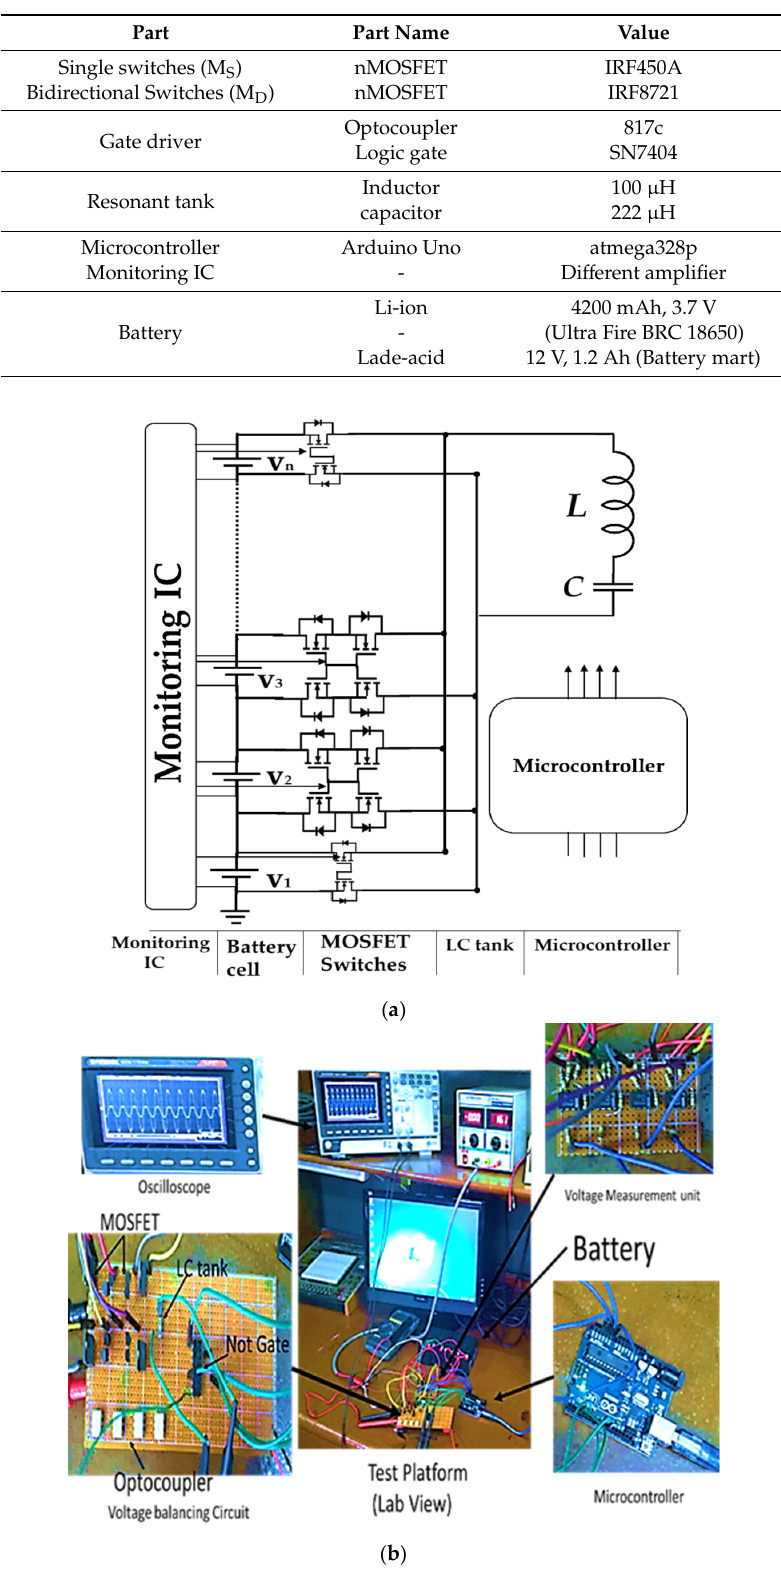
Figure 9. Hardware development: ( a ) schematic diagram of the balancing circuit and ( b ) experimental setup in a